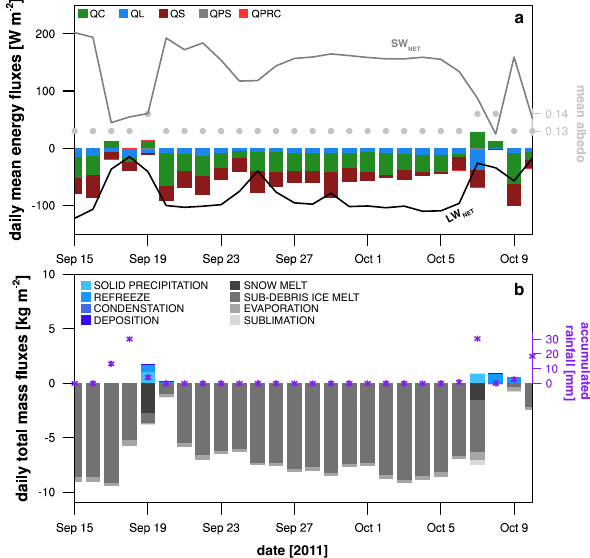
Figure 10. Same as Fig. 6 but for the 2011